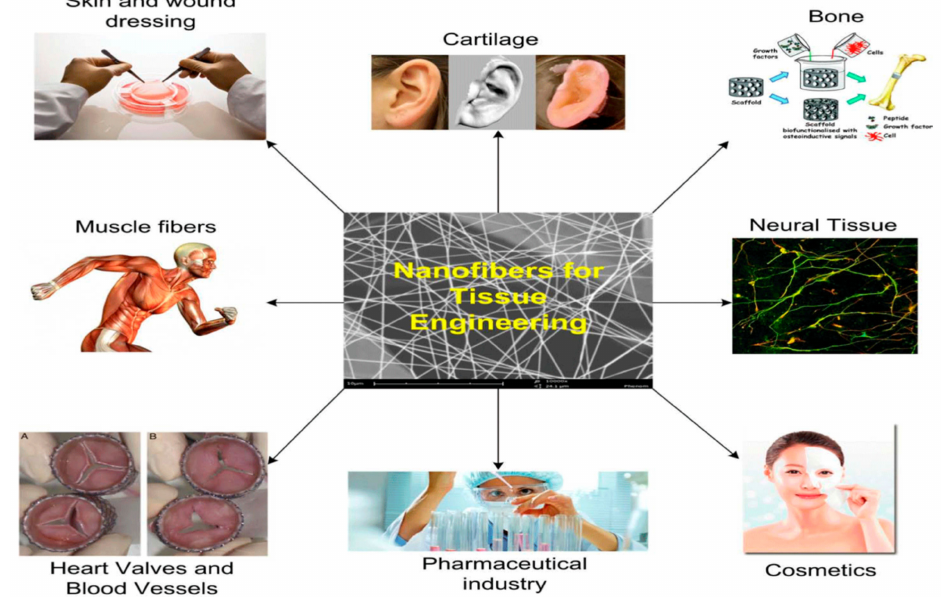
Figure 4. A schematic of the applications of tissue engineering